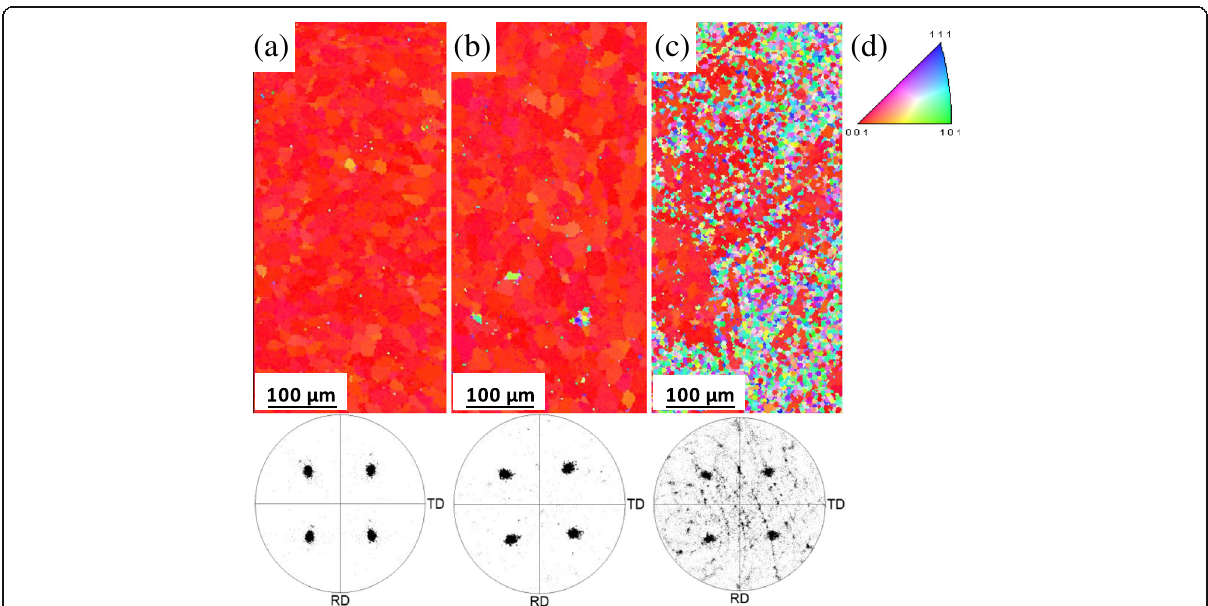
Fig. 5 EBSD maps and the corresponding (111) pole figure of STO films grown at a chamber pressure, laser frequency, and substrate temperature of 10 − 4 mbar, 10 Hz, and 500 °C, respectively, with a thickness of a 500 nm, b 800 nm, c 1000 nm, and d color key for crystal orientation map